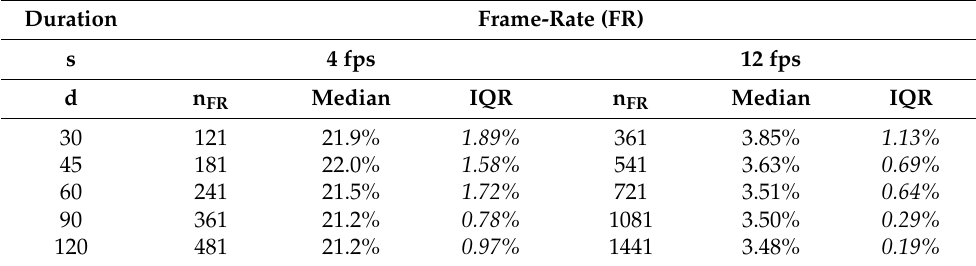
Table 3. Analysis with fixed frame-rate FR (4 and 12 fps) and variable sequence duration d (30, 45, 60, 90 and 120 s) for the ID-CON ( ideal and constant size ) scheme and the LD-F ( low density and fast velocity case ) configuration. For each case, the number of elaborated frames (n FR ), the median MAPE and the IQR (in italic) are